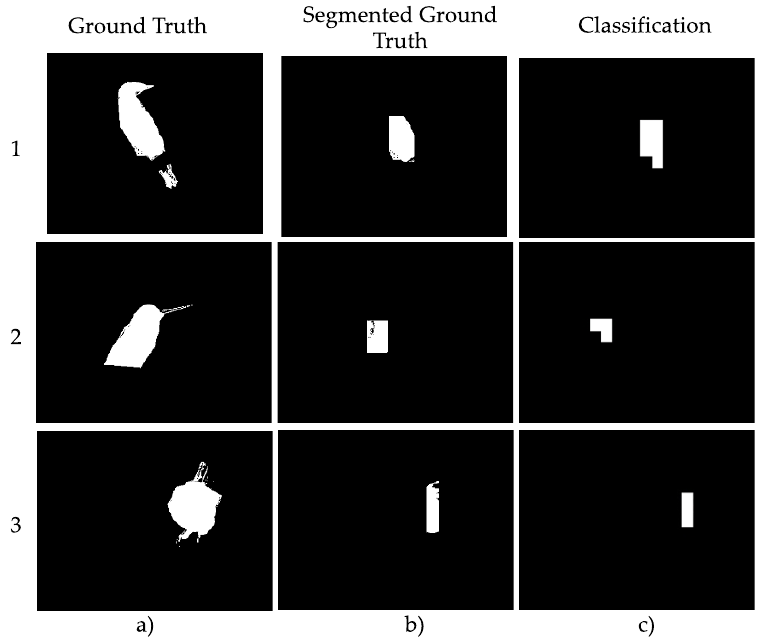
Figure 15. Comparative methodology results for three medium images with occlusion. ( a ) original segmented image, ( b ) segmented image by proposed segmentation, ( c ) 15 × 15-pixel window classification. Note: the images were amplified for better illustration.